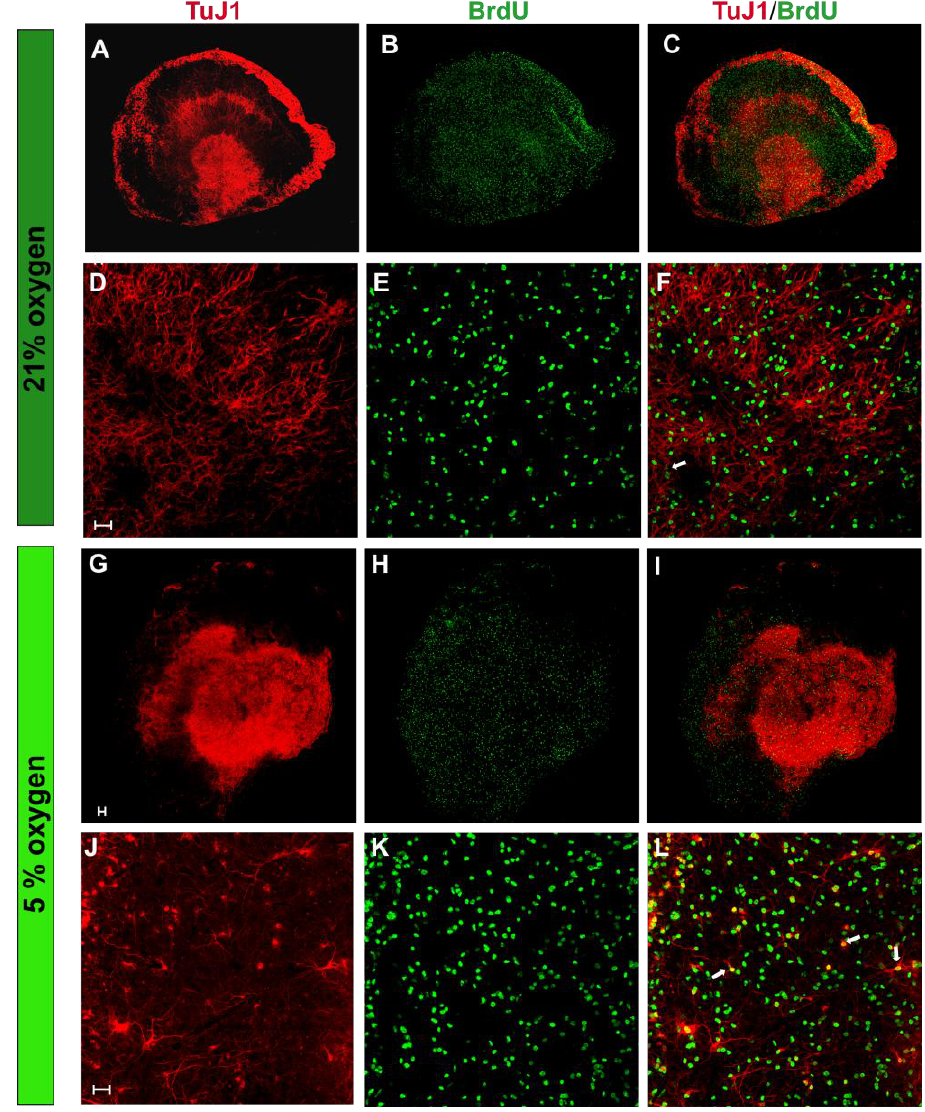
Figure 8. Proliferating neurons within hippocampal slices cultured for 7 DIV, visualized by TuJ1 antibody ( red ) and BrdU ( green ) in the cell nuclei of the dividing cells. ( A – C ) The tile scan of an entire hippocampal slice cultured in standard oxygen conditions (21% O 2 ); ( D – F ) Magnification of the hippocampal slice, allowing to distinguish the double-labelled (TuJ1 + /BrdU + ) dividing cells ( white arrows ); ( G – I ) Tile scan of an hippocampal slice cultured in physiologically normoxic conditions (5% O 2 ); ( J – L ) Enlargement of the slice, showing the colocalization of the neuronal marker (Tuj1) and BrdU, staining the newly derived cells (whithe arrows). The scale bar is equivalent of 50 µ m. The evaluation of the total content of differentiating oligodendrocytes in the hippocampal slices after 7 days in distinct oxygen concentrations also revealed significant differences. While CNP + cells accounted for approximately 132 ± 21.65 per 606.3 µ m × 606.3 µ m area in